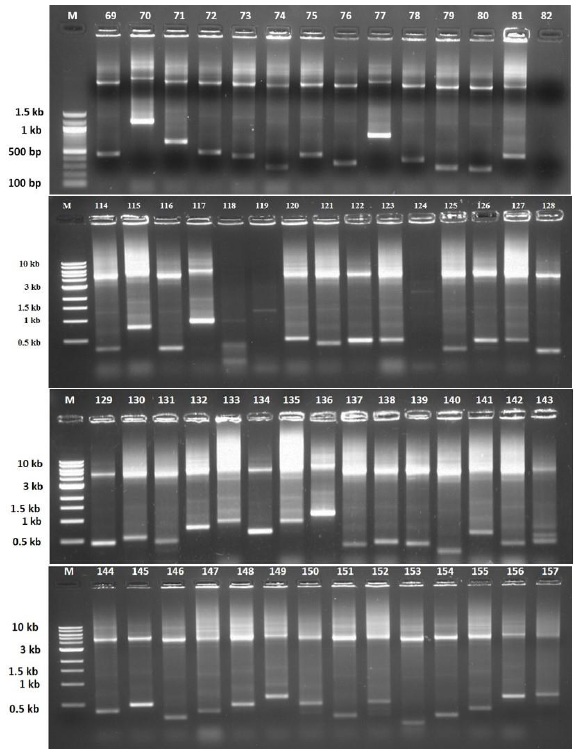
Figure 9. Colony PCR of randomly picked white colonies with universal M13 forward and reverse primers. Out of several colonies screened, sixty-six positive colonies were found to harbor different insert sizes. Lane M is the marker DNA of the indicated size, and Lanes 69–157 are the sixty-six positive